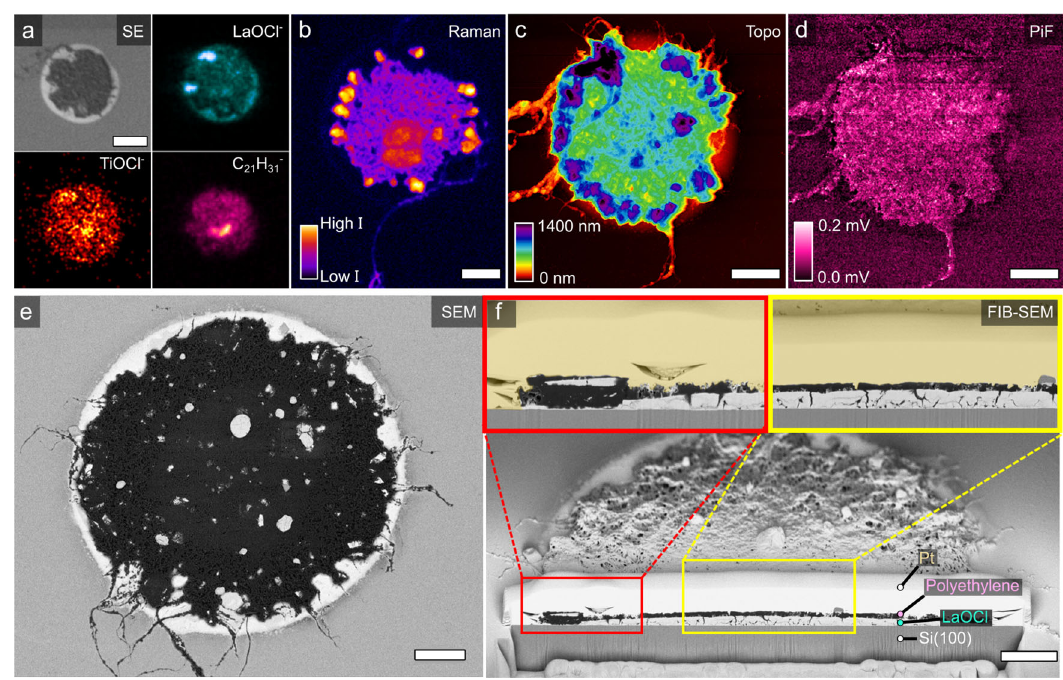
Fig.2|Anoverviewofthemicro-spectroscopictoolboxutilizedinthisworkto study the interplay betweenthe formedpolyethyleneand the LaOCl spherical cap model system demonstrated after 20min of ethylene polymerization. a Time-of- fl ight secondary ion mass spectrometry (ToF-SIMS) that provides a dis- tributionofthenegativelychargedmassspeciespresentonthesurface,suchasthe selectedLaOCl − ,TiOCl − andpolyethylenecharacteristicC 21 H 31 − fragments. b Raman microscopymapof the2700 – 3100cm − 1 regionshowsthe-CH stretchingmodesof polyethylene on a different LaOCl spherical cap. c , d Combined photo-induced force microscopy (PiFM) results that give both topological and morphological information in c and distribution of the summed δ (CH 2 ) peaks at respectively